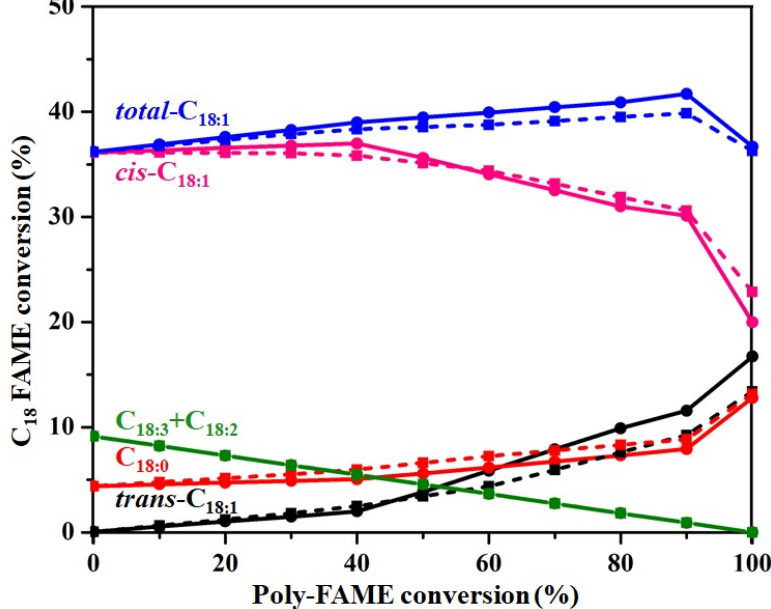
Figure 10. C18 FAME composition in the H-FAME product at different poly-FAME conversion levels over the Pd/NPC-H (solid line) and Pd/NPC-K (dashed line) catalysts. Table 5. Initial rate, FAME composition, and biodiesel properties of palm-BDF and H-FAME over the prepared Pd/NPC catalysts at a poly-FAME conversion level of 90%.